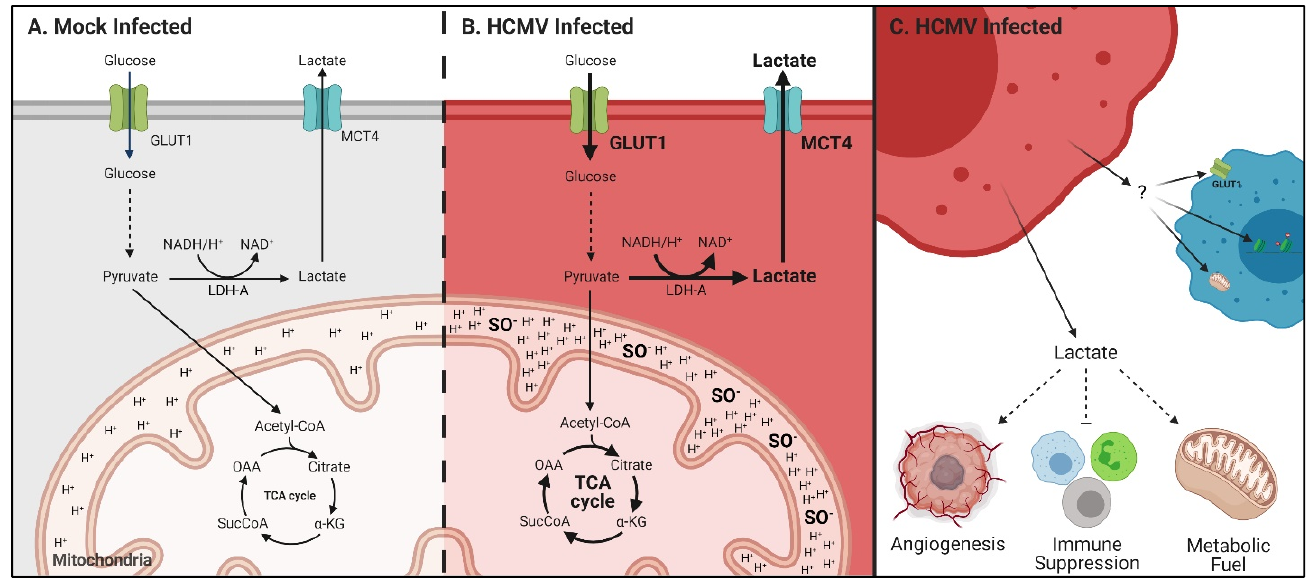
Figure 8. Metabolic reprogramming and paracrine effects of HCMV infection in glioblastoma. Schematic of glycolysis and respiration in ( A ) mock- and ( B ) HCMV-infected cells highlighting upregulation of GLUT1 and MCT4 expression; increased lactate production and export; enhanced respiration and resultant increases in mitochondrial membrane potential and superoxide